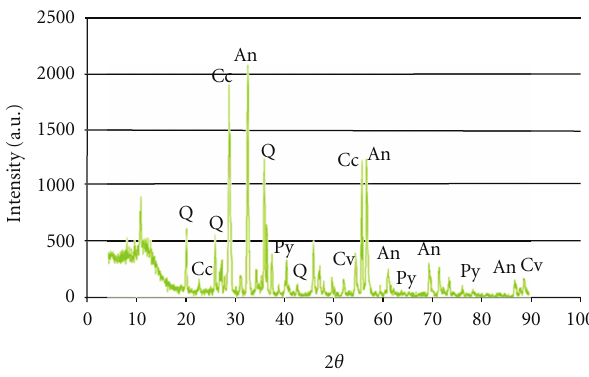
Figure 4: Major mineralogical phases obtained by X-ray di ff raction (XRD). An: andradite (Ca 3 Fe 2 (SiO 4 ) 3 ); Cc: calcite (CaCO 3 ); Cv: covellite (CuS); Q: quartz (SiO 2 ); Py: pyrite (FeS 2